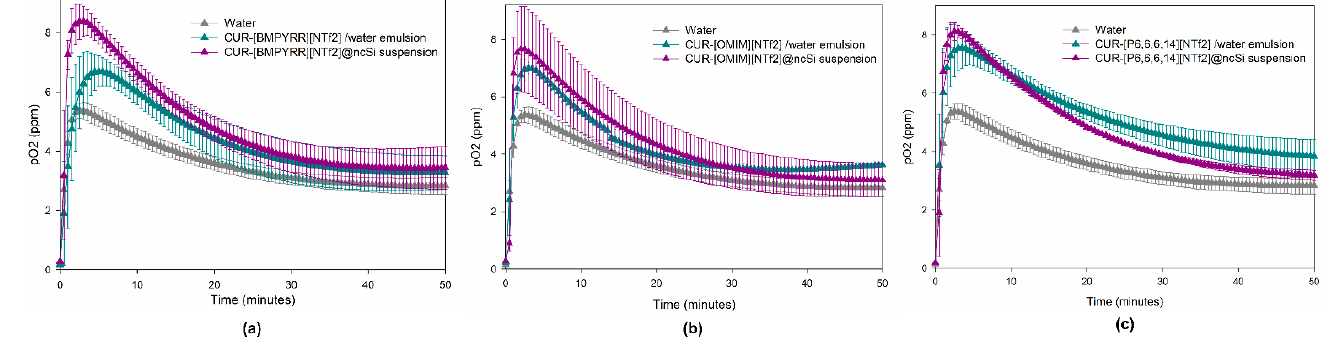
Figure 4. Evolution of the oxygen concentration in deoxygenated water after the addition of: (i) oxygenated CUR-IL@ncSi suspension samples; (ii) oxygenated IL/water emulsion samples; and (iii) oxygenated water samples (control). ( a ) [BMPYRR][NTf 2 ]; ( b ) [OMIM][NTf 2 ]; and ( c ) [P 6,6,6,14 ][NTf 2 ].